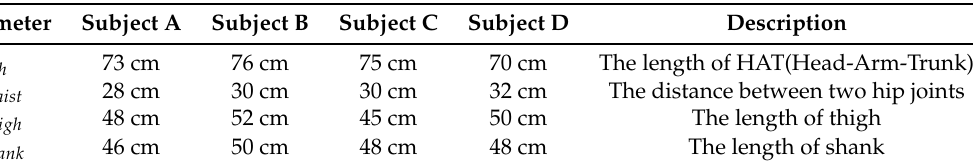
Table 1. The parameters of subjects.